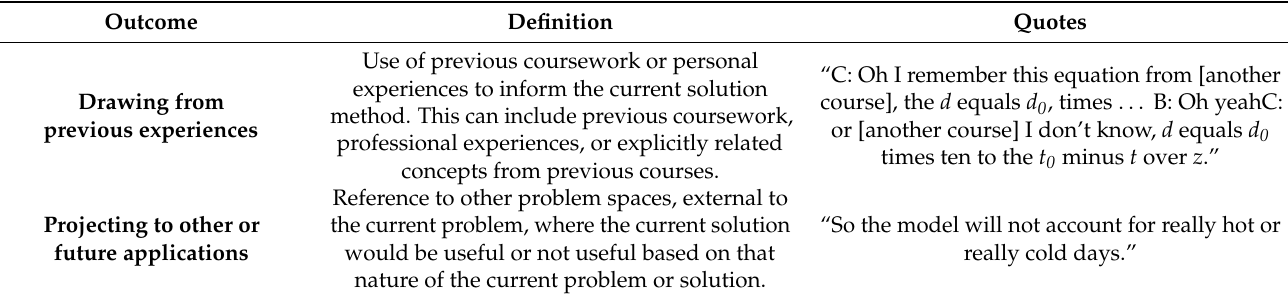
Table 7. Definitions and quotes of CT outcomes identified for generalization (letters denote individual deidentified students).